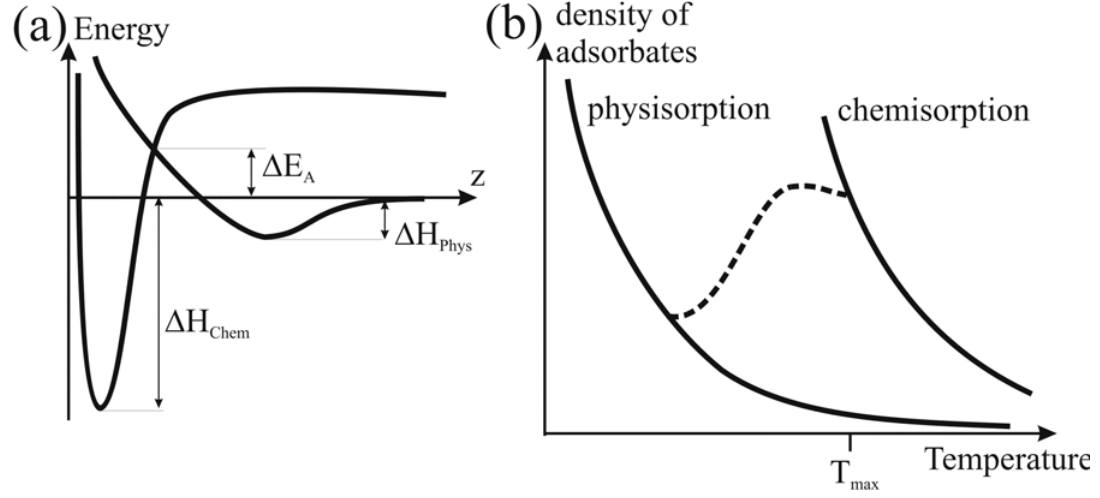
Figure 1 . (a) Lenard-Jones model for physisorption and chemisorption of molecules. Typical adsorption isobars are shown in (b). The solid lines are equilibrium physisorption and chemisorption isobars, the dashed line represents irreversible chemisorption. A maximum coverage of chemisorbed molecules is obtained at T . (reproduced with permission from ref. [ 37 max